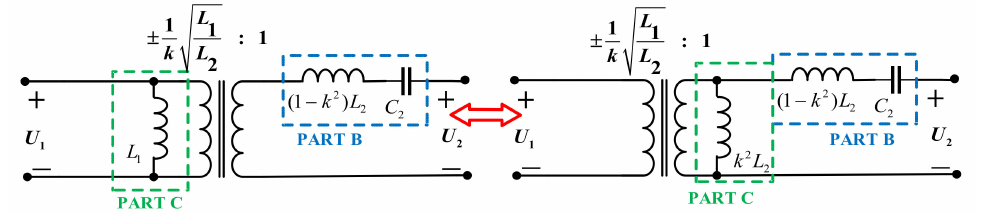
Figure 6. The equivalent model of the I_CV_CV